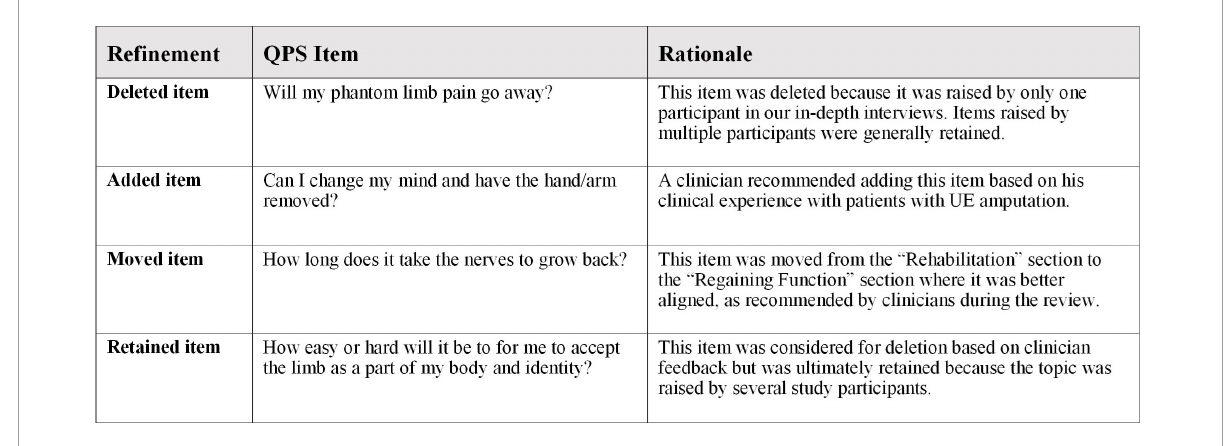
the preliminary UE VCA-QPS included categorized into 12